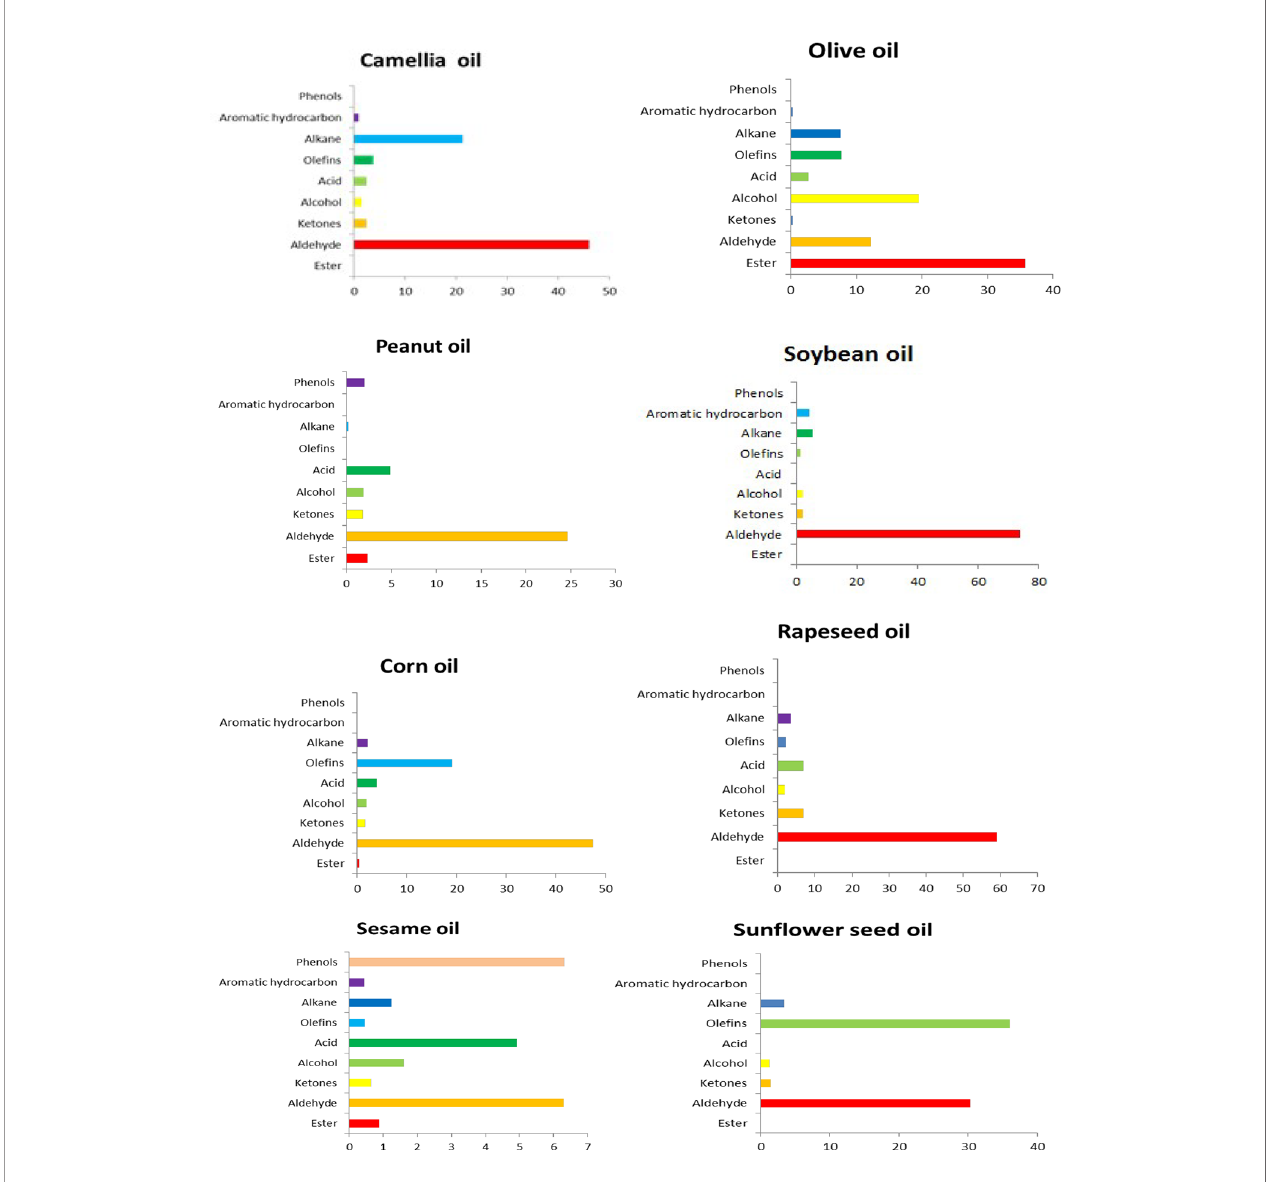
FIGURE 3 | A comparison of different fl avor substances in EPOs